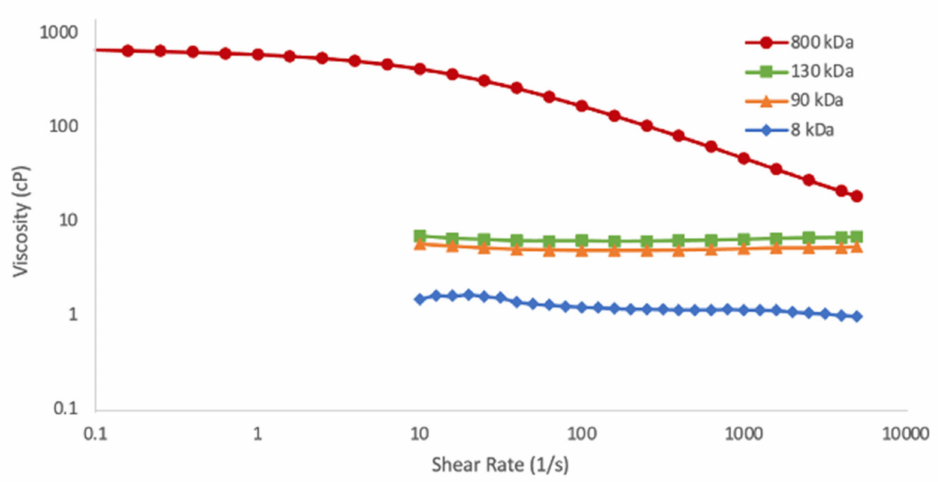
Figure 1. Effect of HA molecular weight on viscosity vs. shear